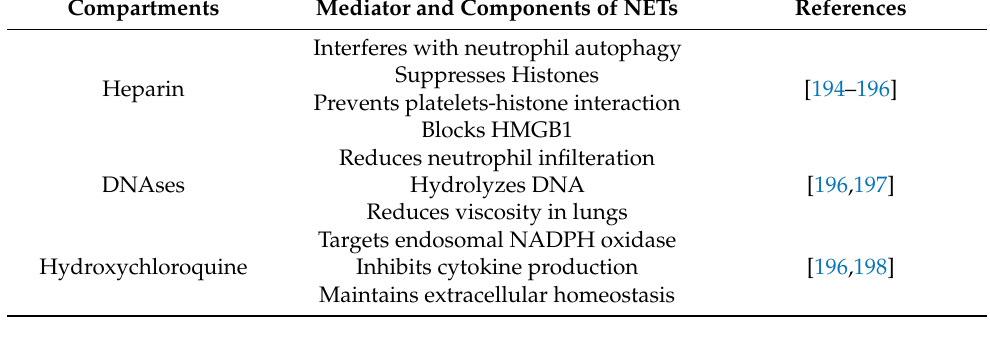
Table 3. Potential Anti-NET Therapeutics: Heparin, DNAse and Hydroxychloroquine.